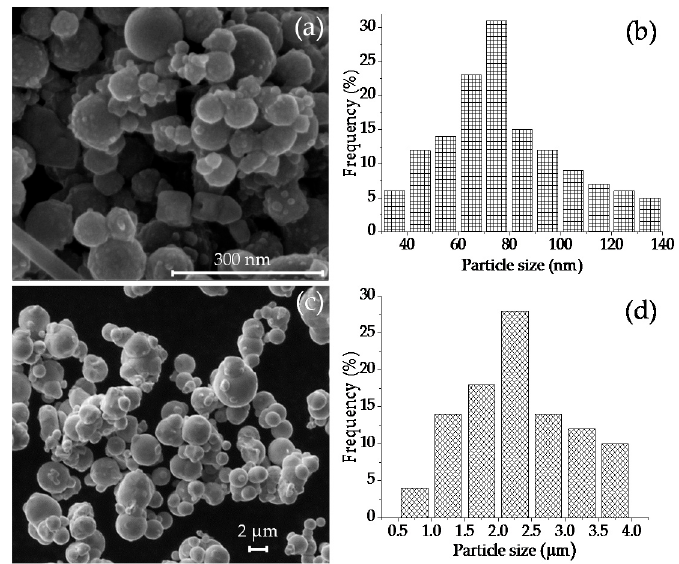
Figure 10. ( a , c ) illustrate SEM images of nano- and microparticles, while illustrations ( b , d ) exhibit their corresponding particle statistical distribution size.